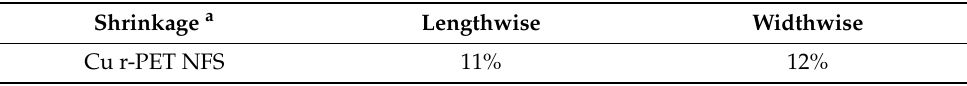
Table 6. Shrinkage of the r-PET nanofibers after the ELD process. Shrinkage a